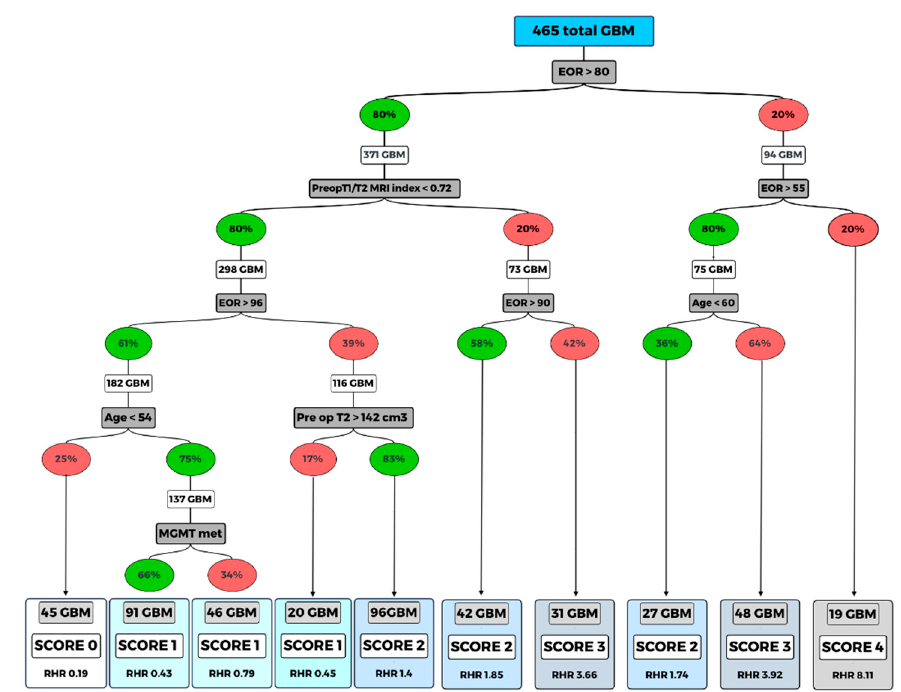
Figure 4. Random forest (classification and regression tree, CART).